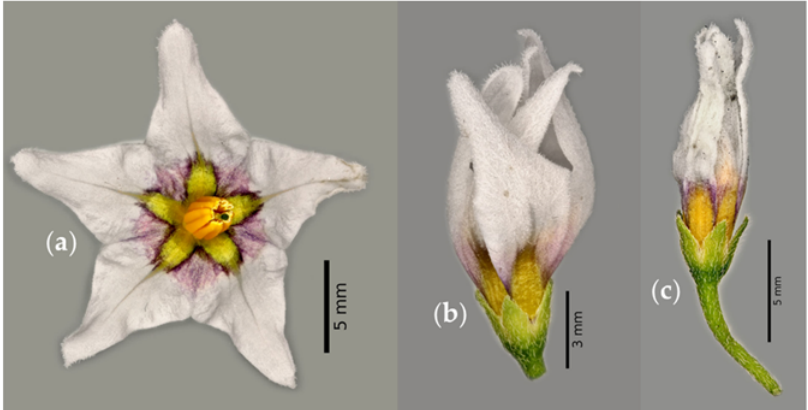
Figure 11. Flower of slender nightshade plant ( Solanum nigrescens ) open ( a ) and with 80 ( b ) and 90% closed flowers ( c ). Photos by Jorge Manuel Valdez-Carrasco.